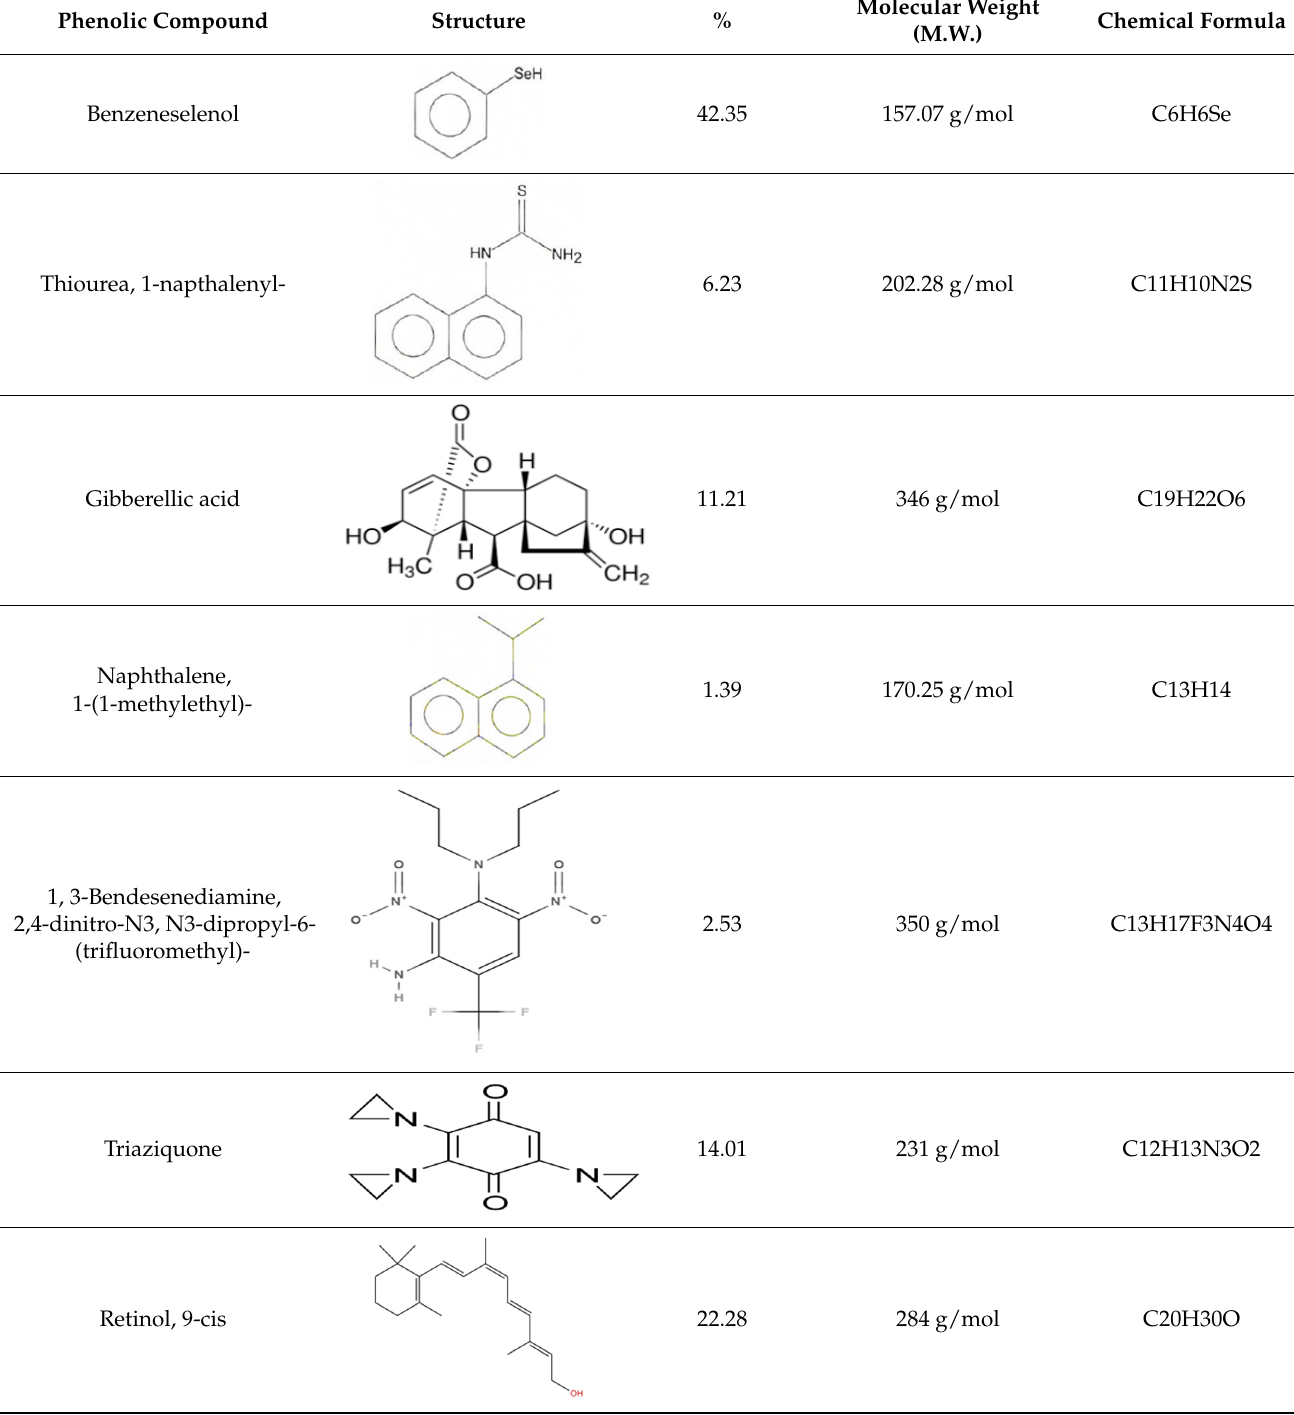
Table 5. Qualitative phytochemical analysis showing the phenolic constituents of the ethanolic extract of T. aphylla .